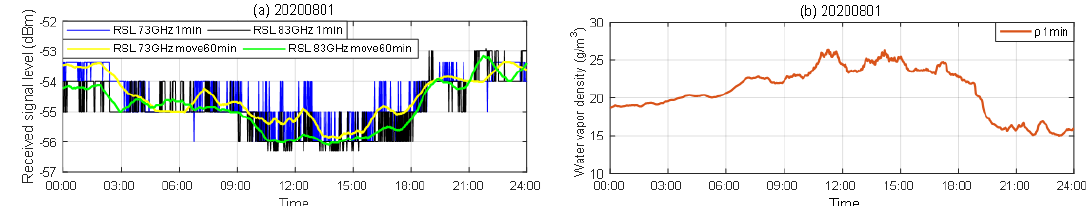
Figure 2. (a) Comparison of the link received signal level (RSL) before and after sliding on 1 August 2020 (CST). (b) Water vapor density ρ calculated from weather station